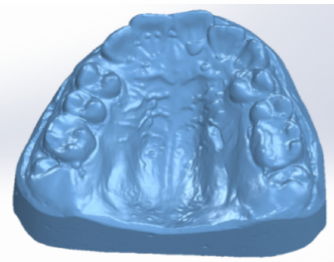
Figure 6. Perfectly closed surface obtained after the filling operation.